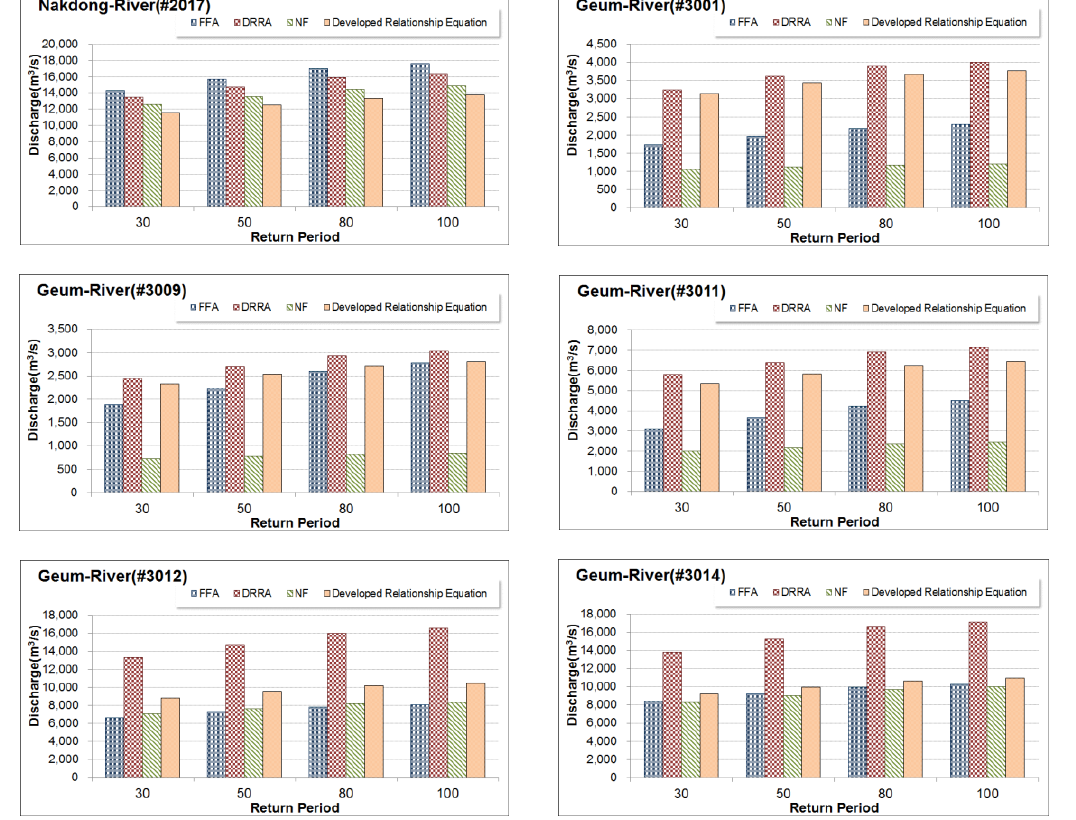
Figure 3. Design floods estimated by various methods.